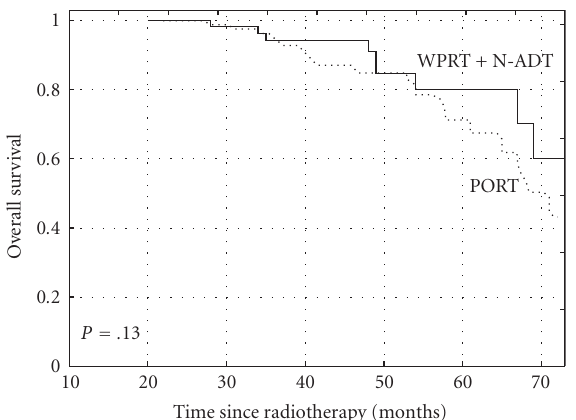
Figure 1: The Kaplan-Meier curves comparing overall survival (OS) for patients at high risk of nodal involvement, as defined in text receiving whole pelvic radiotherapy (WPRT) combined with neoadjuvant androgen deprivation therapy (N-ADT) or prostate radiotherapy only (PORT), ( P = . 13).